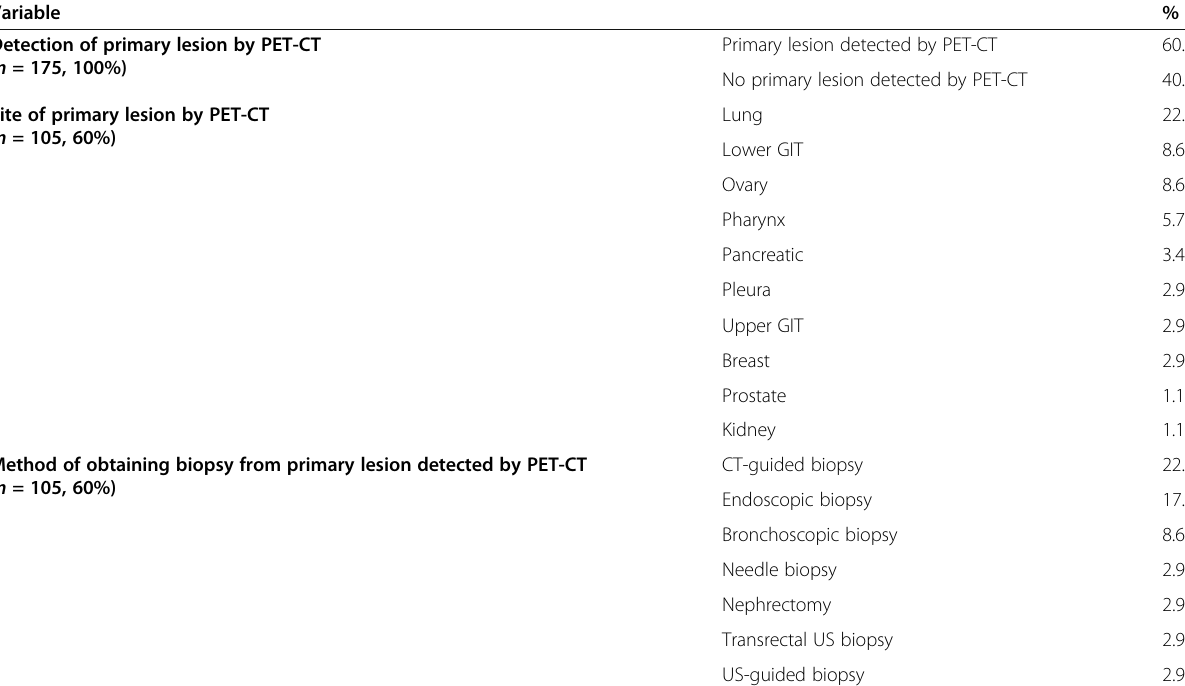
Table 3 The sites of primary tumors detected by PET-CT and the methods of obtaining biopsy to confirm/exclude their malignant nature Variable % Detection of primary lesion by PET-CT ( n = 175, 100%)